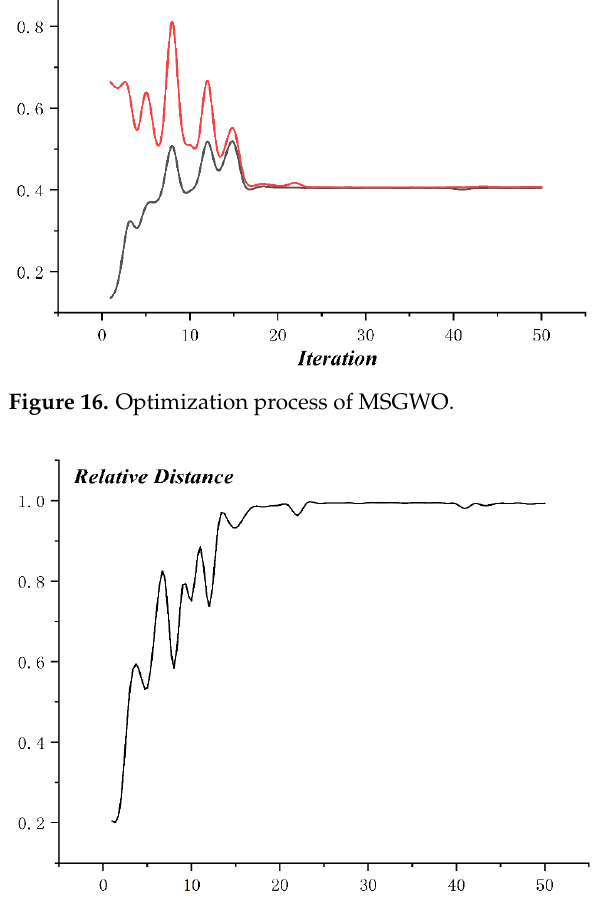
Figure 17. Relative distance of